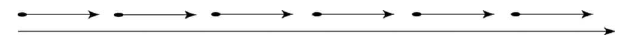
FIG. 1. Motion map of an object moving at a constant positive